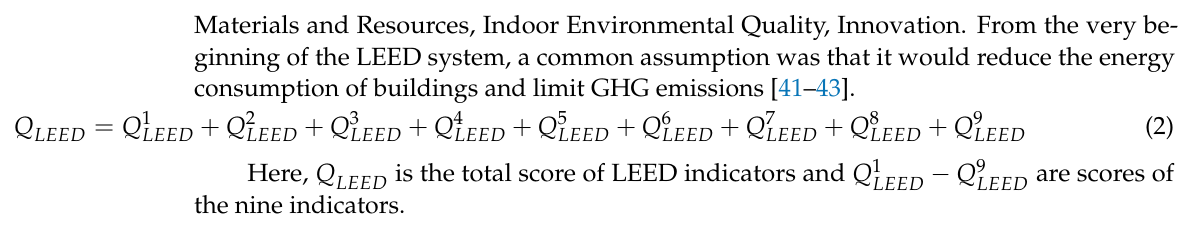
Table 2. Criteria of LEEDv4.1 BD + C.